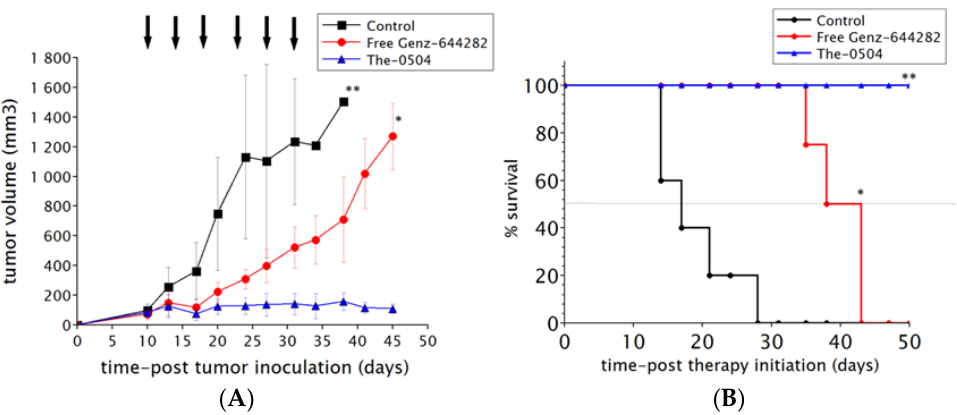
Figure 5. In vivo efficacy. ( A ) Tumor-growth curves for each mouse group are indicated. Student's t- test is used to determine statistical significance. Control vs The-0504 and Control vs Free Genz-644282: ** p < 0.005; Free Genz-644282 vs The-0504: * p < 0.05. ( B ) Survival curves of different animal groups. Mice were sacrificed when the tumor had reached a volume in the range 1000–1500 mm 3 . Statistical analysis was performed by log-rank test. Control vs The-0504, and Control vs Free Genz-644282: ** p < 0.005; Free Genz-644282 vs The-0504 mg/Kg: * p < 0.05.